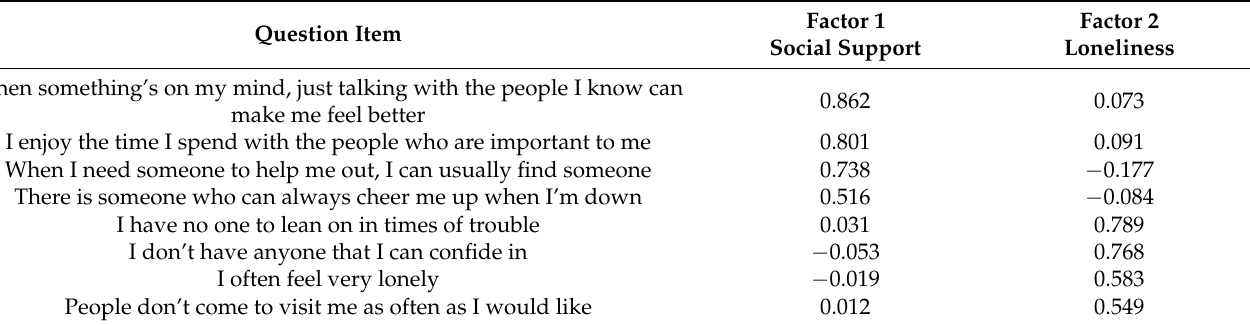
Table A1. Pattern matrix loadings for the two principal axis factors across the eight loneliness and social support items. Question Item